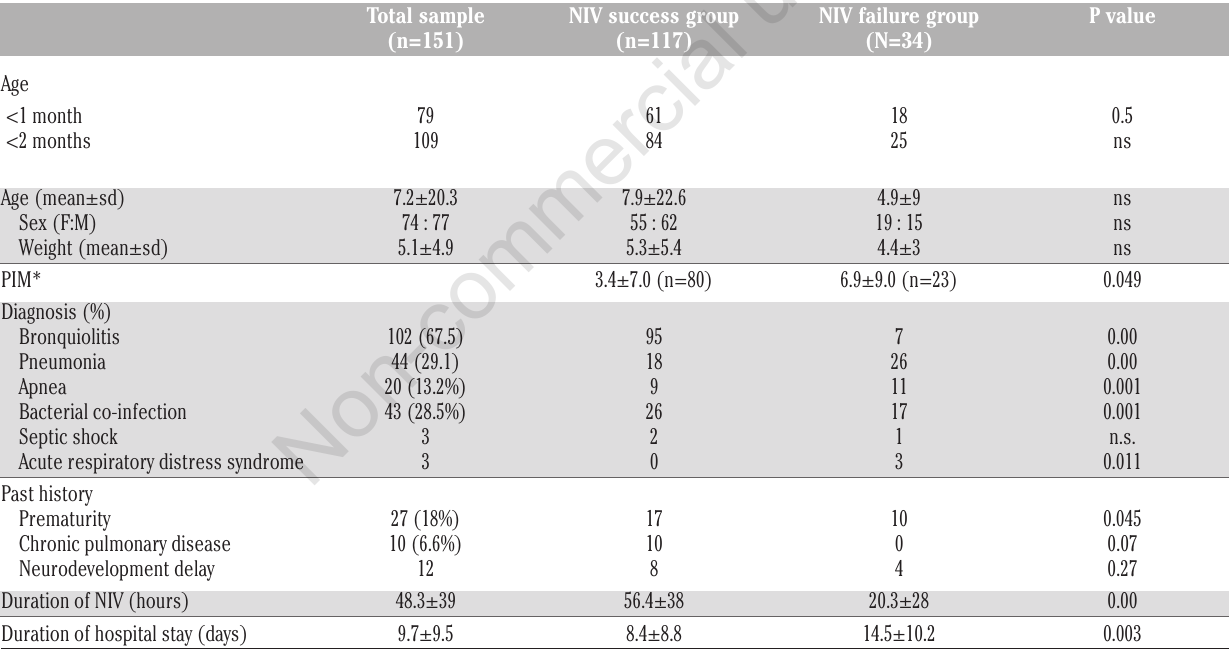
Table 3. Comparison of group A (success) and B (failure) - clinical characteristics - univariate analysis.